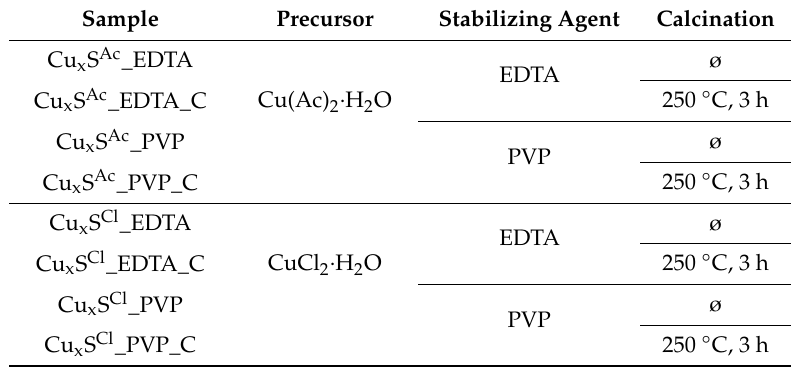
Table 1. The nomenclature, synthesis, and the heat treatment parameters of the Cu x S samples. EDTA: ethylenediaminetetraacetic acid, PVP: